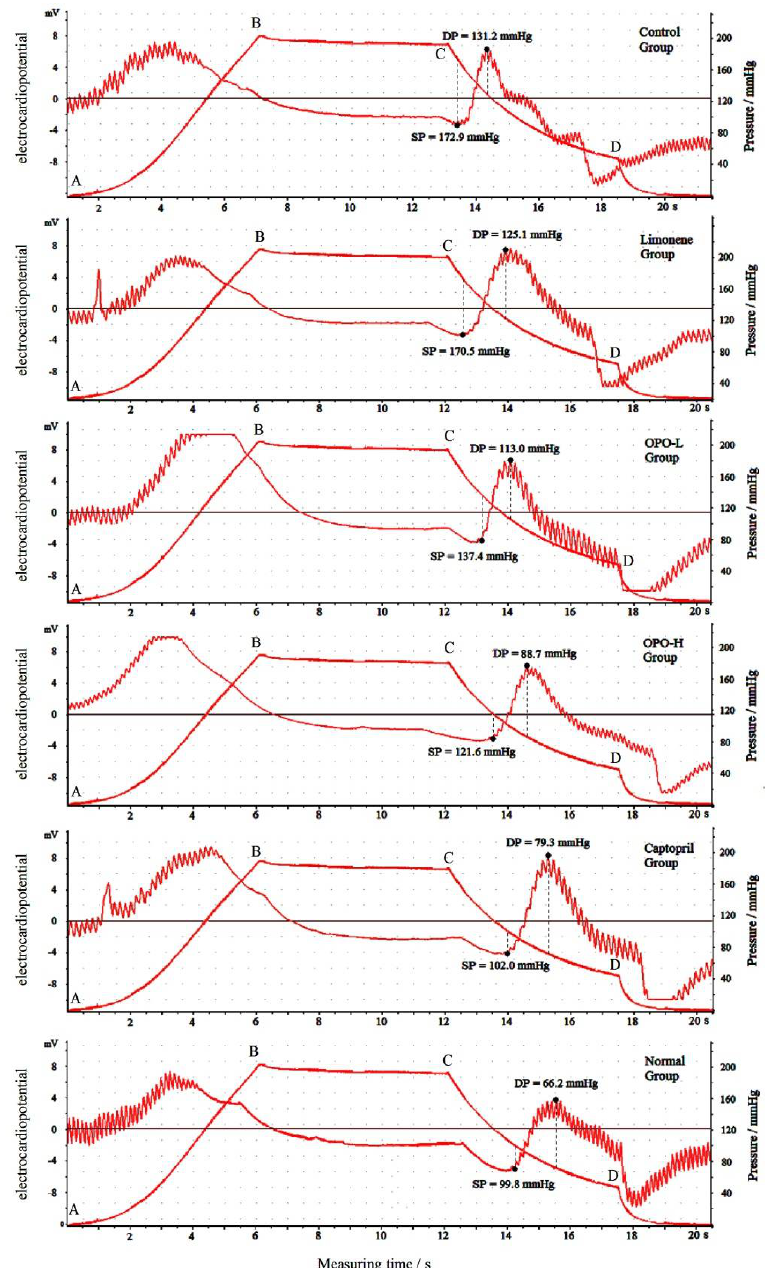
Figure 4. Electrocardiograph and blood pressure of each group during one inflation/deflation cycle of the tail-cuff sphygmomanometry. Notes: The recorded voltage of the electrocardiograph corresponds to the left ordinate. The right ordinate corresponds to the blood pressure diagram, in which: A, start inflation; B, stop inflation and keep pressure; C, start deflation and measurement; and D, stop measurement and vent. SP, systolic pressure; DP, diastolic pressure. OPO-L group, orange peel oil low dose, 5 mL/kg bodyweight (bw); OPO-H group, orange peel oil high dose, 10 mL/kg bw; captopril group, 15.6 mg/kg bw; limonene group, 10 mL/kg